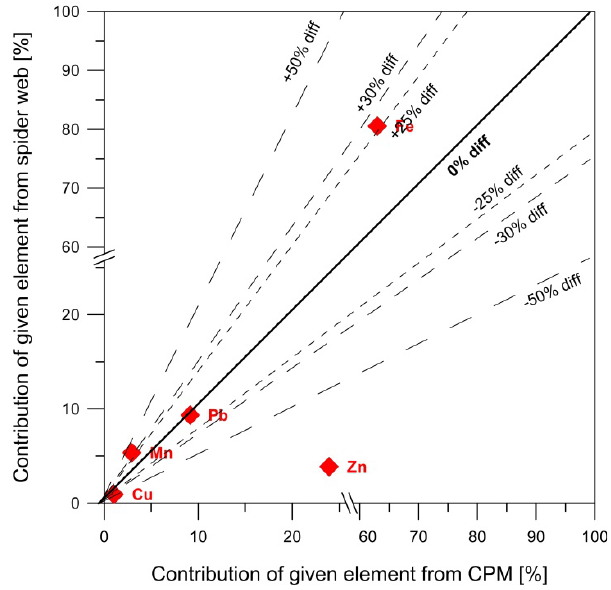
Figure 4. The comparison of both applied methods (spider web and CPM) for assessing the air pollution (% of difference).